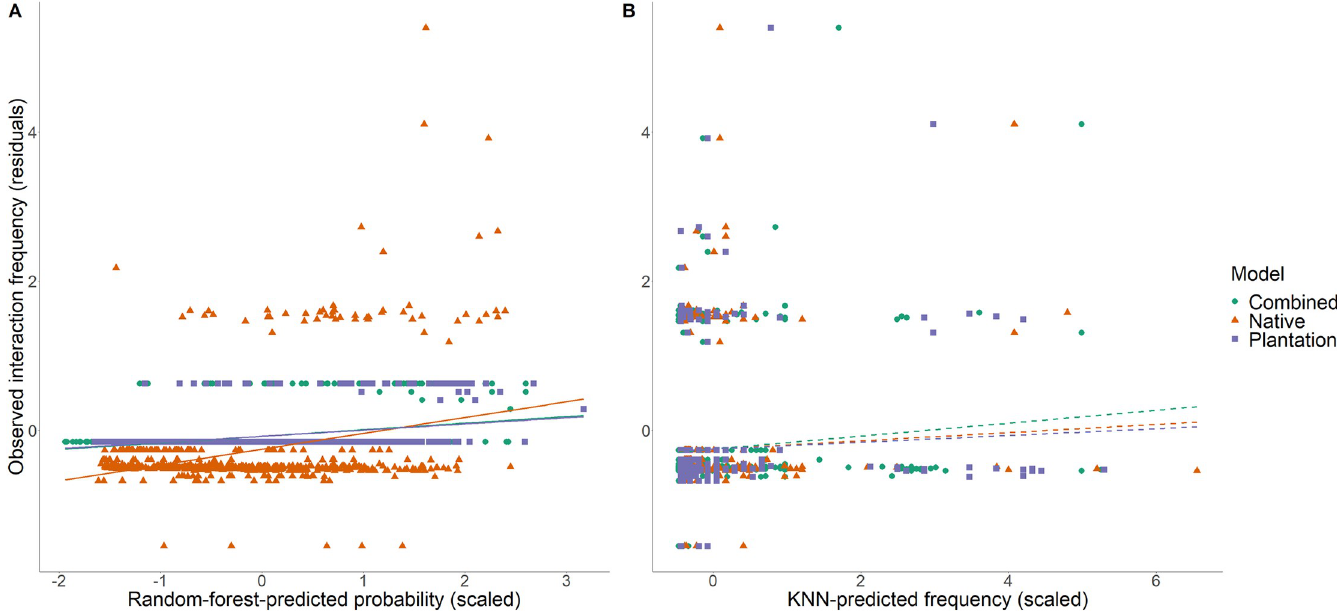
Fig 2. Predictions of observed interaction frequency. (A) Random-forest-predicted probability significantly predicted observed interaction frequency for all three random-forest models (‘combined’, ‘native’, ‘plantation’), whereas (B) KNN-predicted frequency was not retained in any of the best-fitting models (tested using Poisson linear mixed models, and dashed lines represent non-significant relationships). Deviance residuals of the best-fitting model excluding the predictor on the x-axis are plotted, to better reflect the partial effect of the predictor. Each point represents a host-parasitoid species pair present within a site at the first-time step ( t ) test sites.